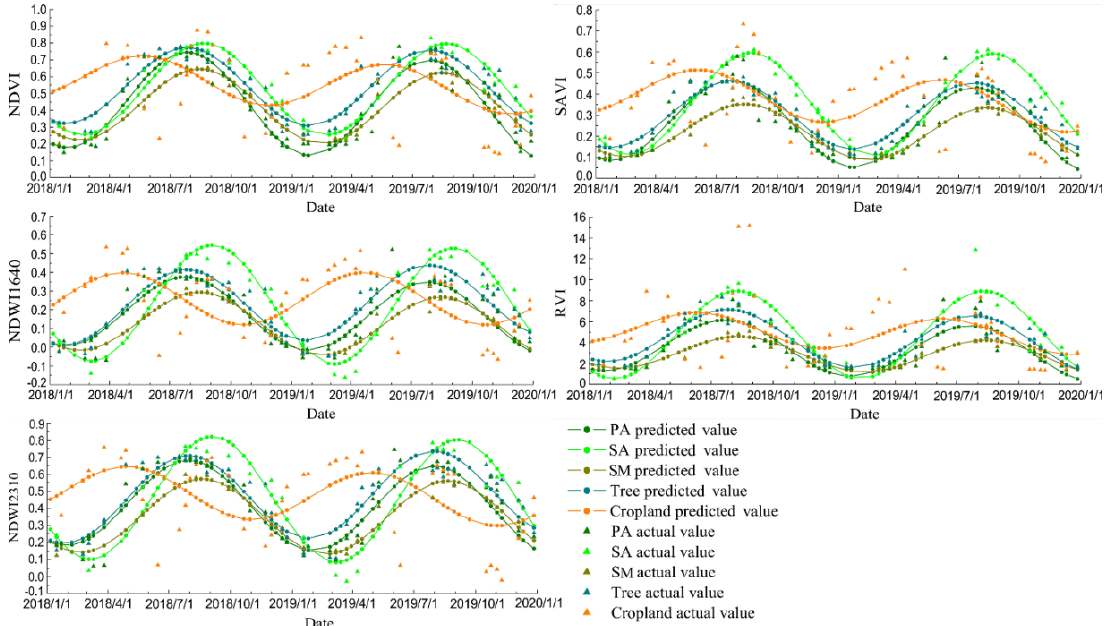
Figure 5. The actual values and predicted values from the harmonic model of wetland vegetation obtained with Landsat images from 2018 to 2020 for the five VIs.